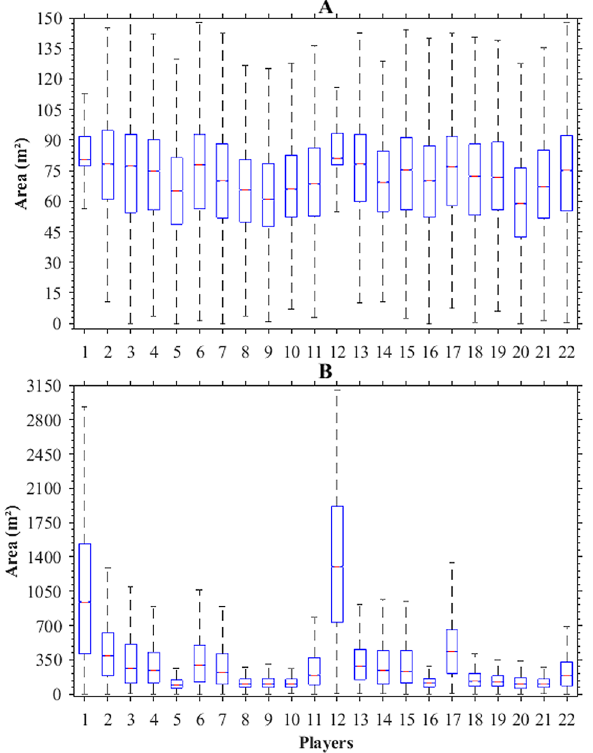
Figure 7. Boxplots represent median (red bars), 25th and 75th percentile (blue boxes), minimum and maximum (black bars) of the dominant region areas (m 2 ) determined by our movement model (A) and Voronoi regions (B) of each